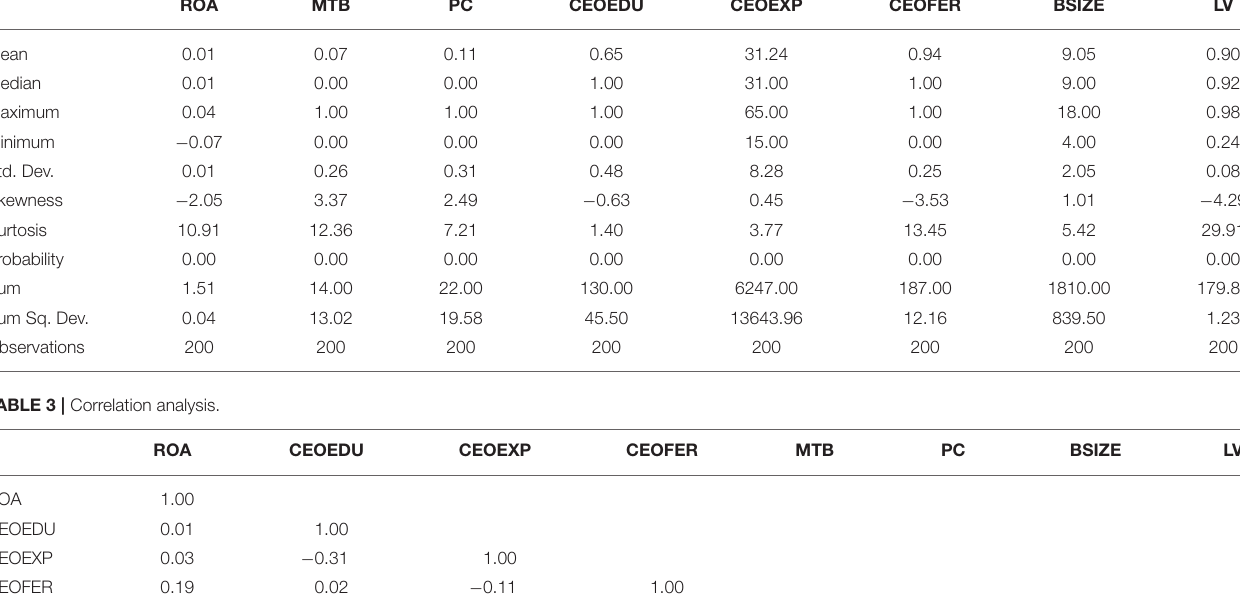
TABLE 2 | Descriptive statistics.